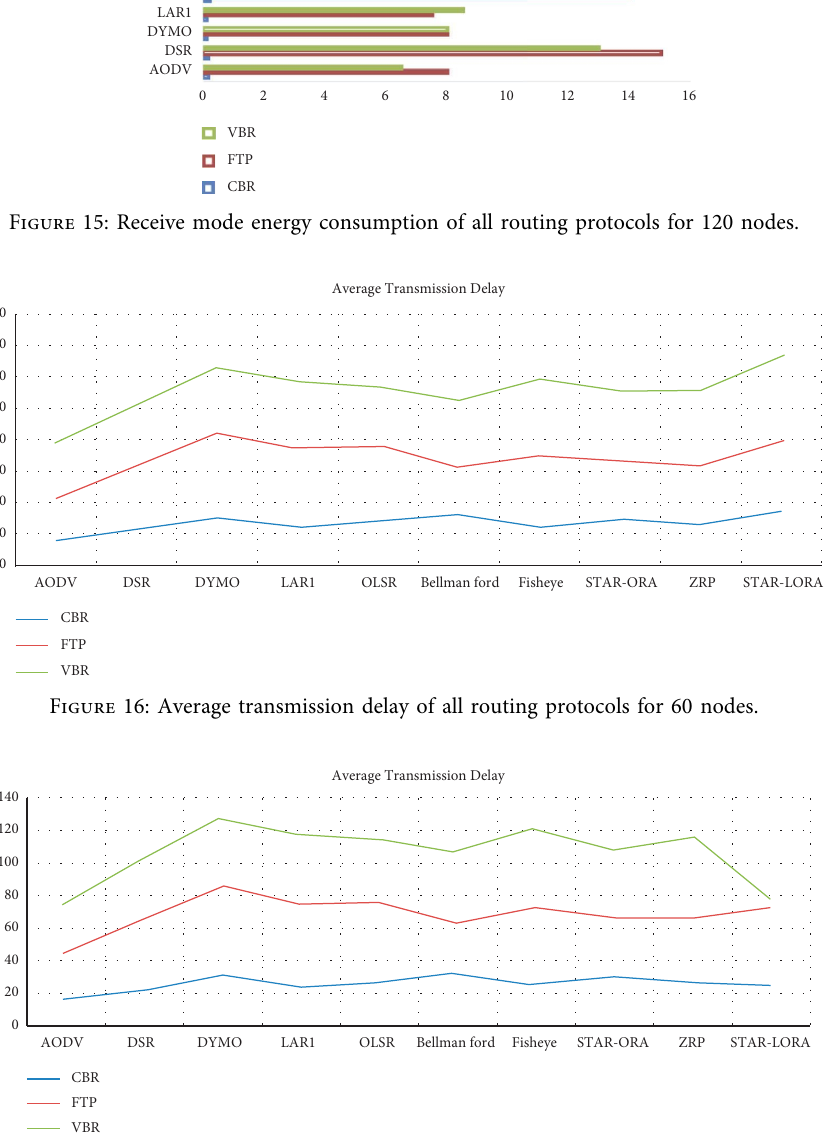
Figure 17: Average transmission delay of all routing protocols for 120